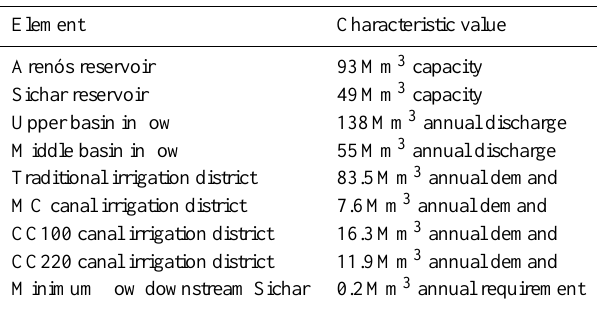
Table 1. Characteristic values of elements of the Mijares River net- work.